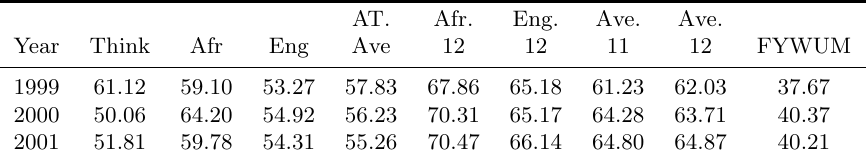
Table 7: Means of the variables of the Test Battery 3 data set for the 1999, 2000 and 2001 intake groups.